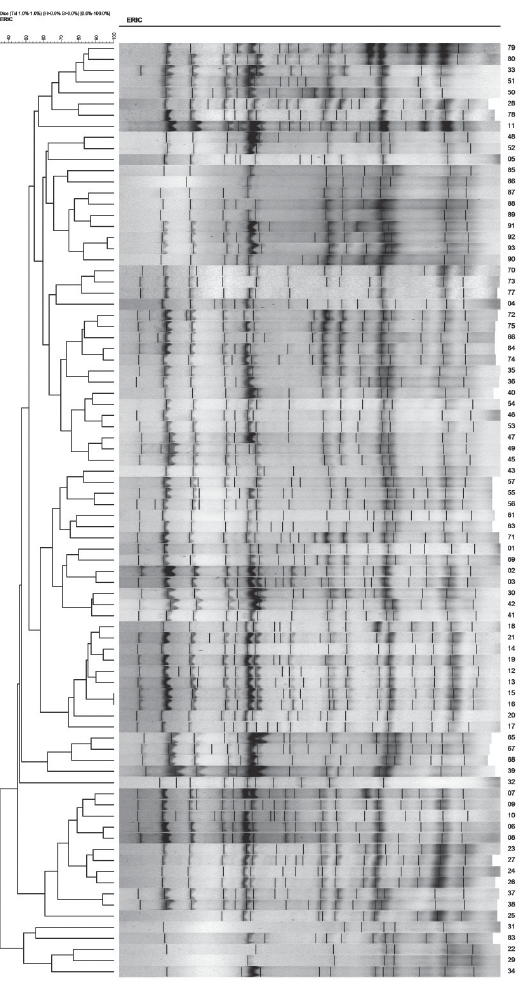
FIGURE 2 - Combined numerical analysis of Mycobacterium tuberculosis clinical isolates from northwestern, Paraná, Brazil, using Enterobacterial Repetitive Intergenic Consensus sequence (ERIC-PCR). The dendrogram was obtained using the BioNumerics software (version 4.45; Applied Maths, Sint- Martens-Latem,